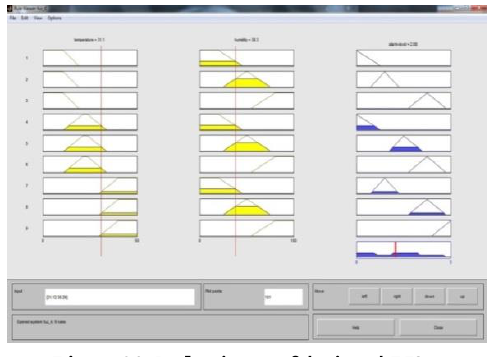
Figure 26. Rule-viewer of designed FIS.